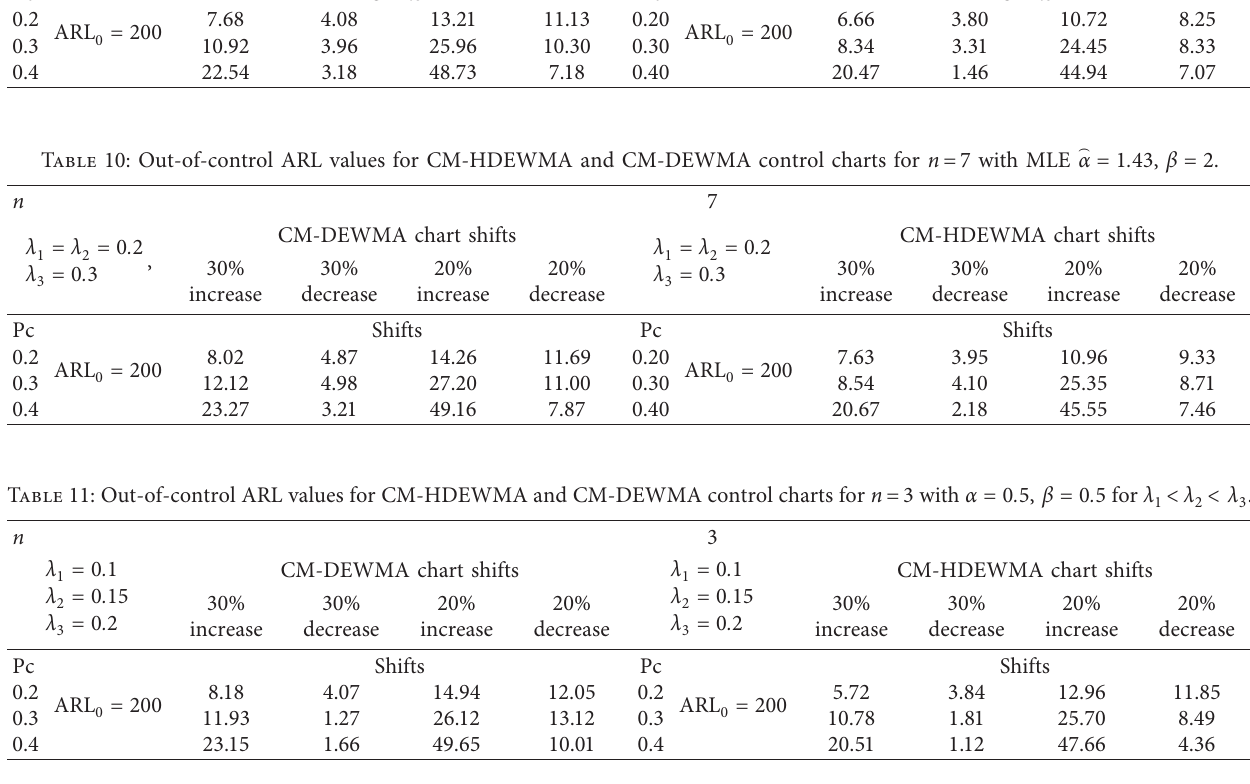
Table 12: Out-of-control ARL values for CM-HDEWMA and CM-DEWMA control charts for n � 3, α � 0 . 5 , β � 0 . 5, and λ n 3 � 0 . 25 λ 1 � 0 . 15 λ 2 � 0 . 1 λ 3